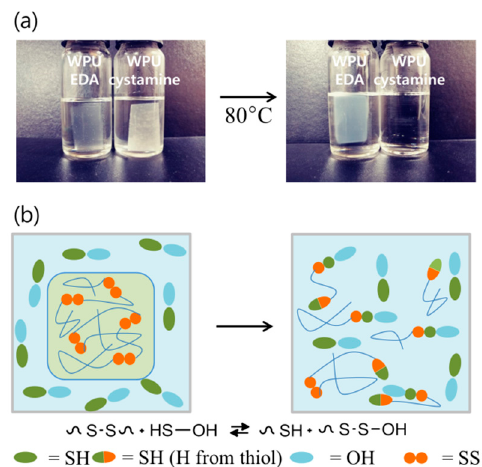
Figure 8. Disintegration of WPU films via the exchange reaction with 2-mercaptoethanol: ( a ) Figure 8. photographs; ( b ) schematic.